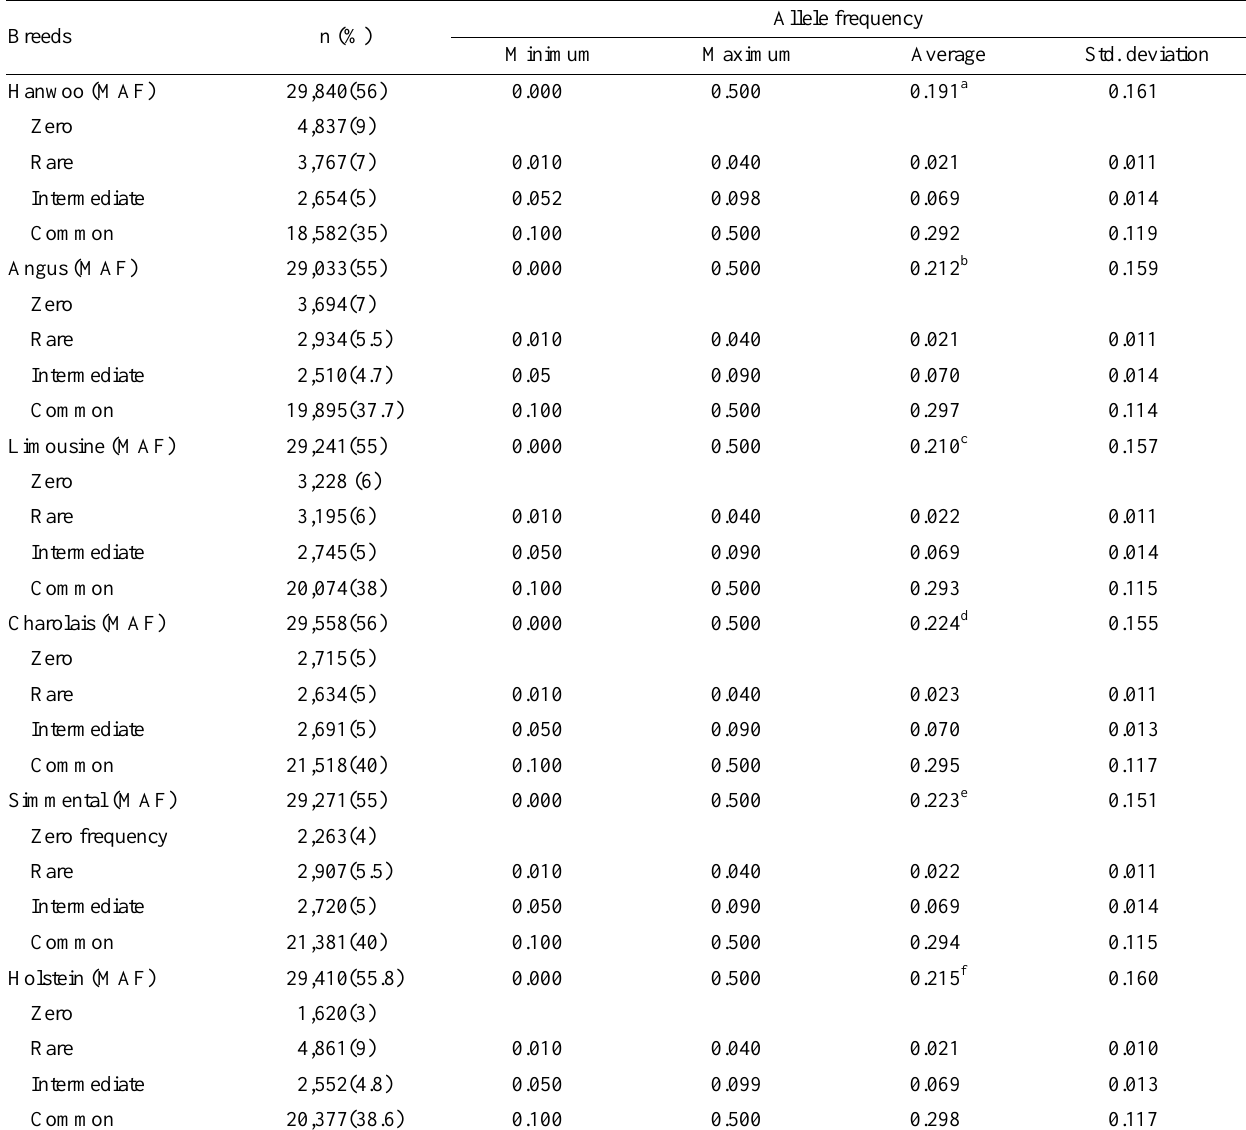
Table 1. Minimum, maximum and mean values for minor allele frequencies observed in each breed